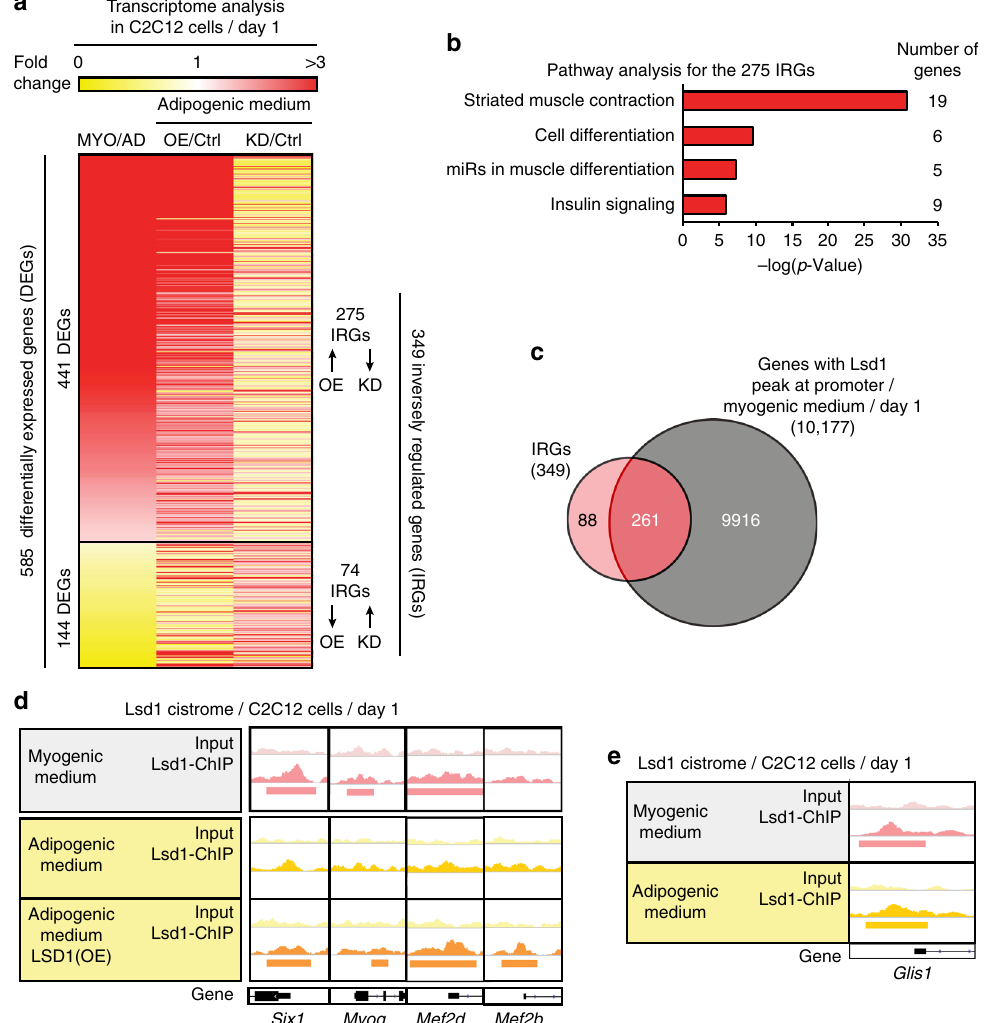
Fig. 5 Lsd1 targets muscle-speci fi c genes under myogenic but not under adipogenic conditions. a Heatmap obtained from RNA-seq analyses depicting differentially expressed genes (DEGs) in: wild-type C2C12 cells differentiated for 1 day in myogenic versus adipogenic medium (MYO/AD, fi rst column), LSD1 overexpressing versus control C2C12 cells (OE/Ctrl, second column), or Lsd1 knockdown versus control C2C12 cells (KD/Ctrl, third column) differentiated for 1 day in adipogenic medium. b Pathway analysis showing signi fi cantly enriched networks for the set of 275 inversely regulated genes (IRGs). c Overlap of all 349 IRGs (pink) obtained from RNA-seq analyses and genes with Lsd1 promoter occupancy (dark gray) obtained from ChIP-seq analyses in C2C12 cells differentiated for 1 day in myogenic medium. d ChIP-seq tracks depicting Lsd1 chromatin occupancy at indicated promoters in wild- type C2C12 cells differentiated for 1 day in myogenic or adipogenic medium or in LSD1 overexpressing [LSD1(OE)] C2C12 cells differentiated for 1 day in adipogenic medium. Identi fi ed peaks are marked with bars. e ChIP-seq tracks depicting Lsd1 chromatin occupancy at the promoter of Glis1 in C2C12 cells differentiated for 1 day in myogenic or adipogenic medium. Identi fi ed peaks are marked with bars. ( a , b : n =